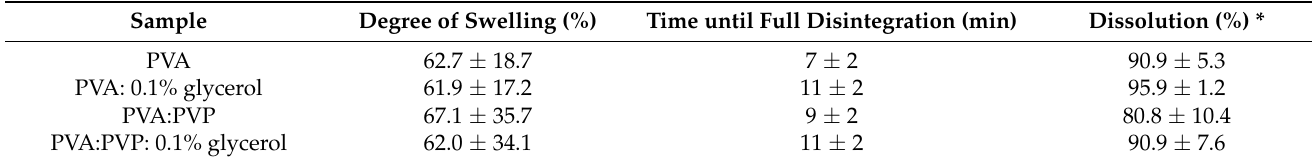
Table 2. Degree of swelling and solubility of PVA 4-88 combined with glycerol and PVP.